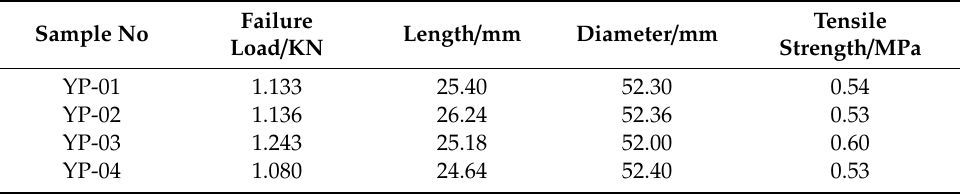
Table 5. Sample tensile strength values.